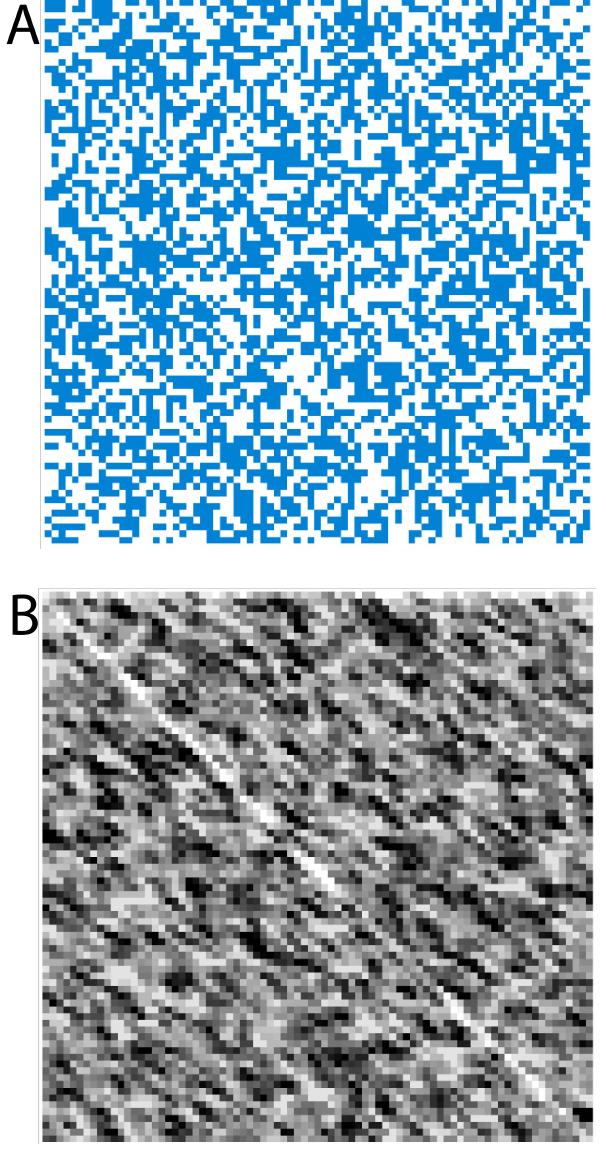
Fig. 4. (A) Cultivated (blue) and non-cultivated fields (white), with cultivated fields receiving additional applied water during the months of April through October, and (B) Net infiltration in the month of July (of the second year) for the true system, with values ranging from 0.000355m day − 1 to 0.006 m day − 1 (represented by white and black, respectively).